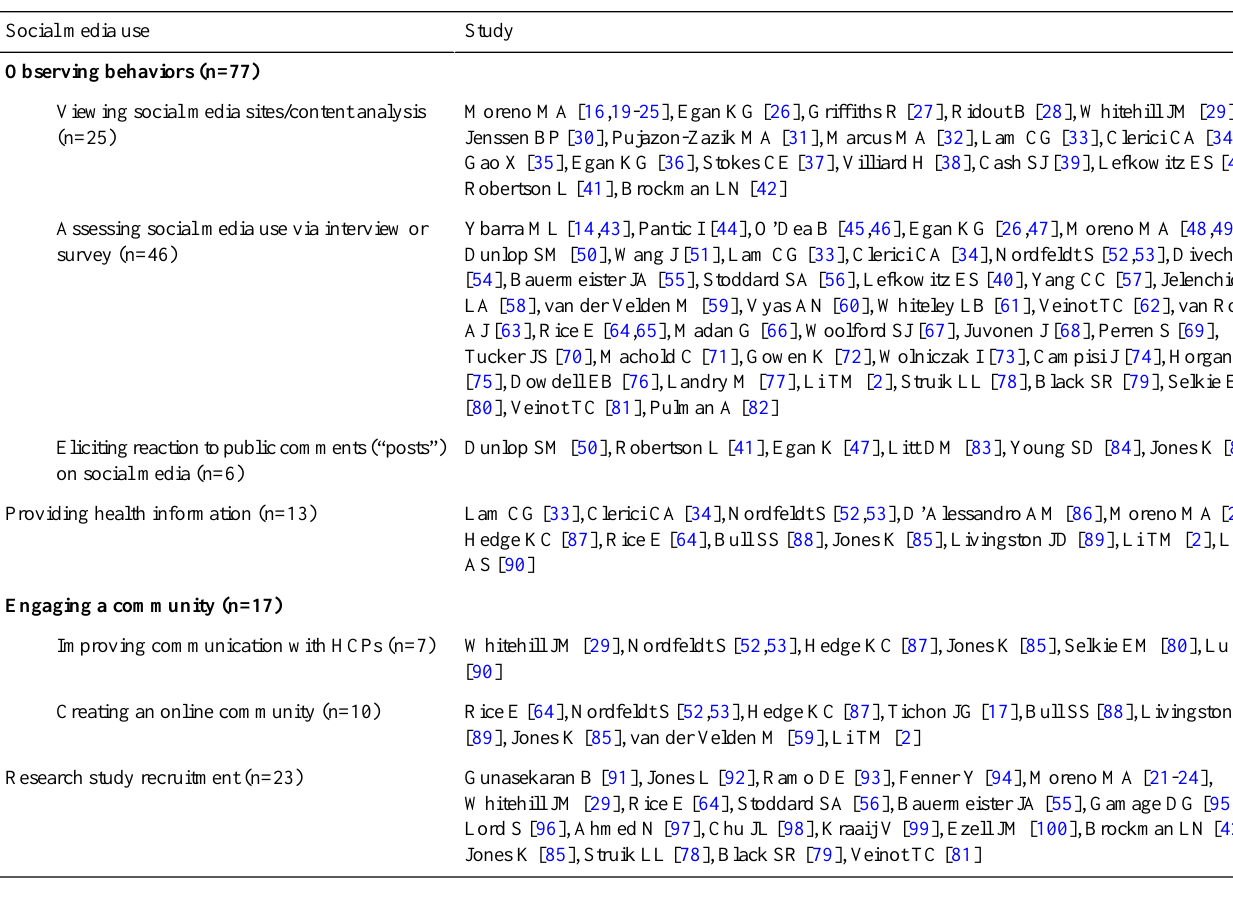
Table 4. Use of social media within research studies.